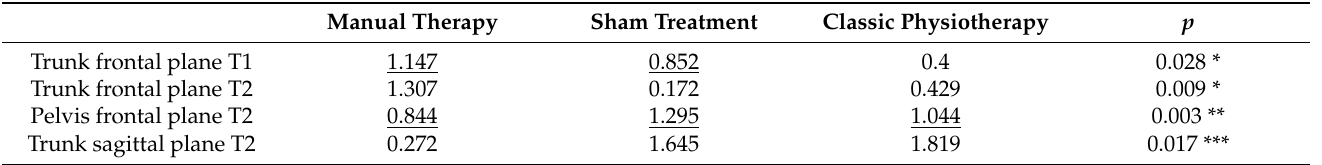
Table 2. Gait symmetry—between-group differences in the R-L